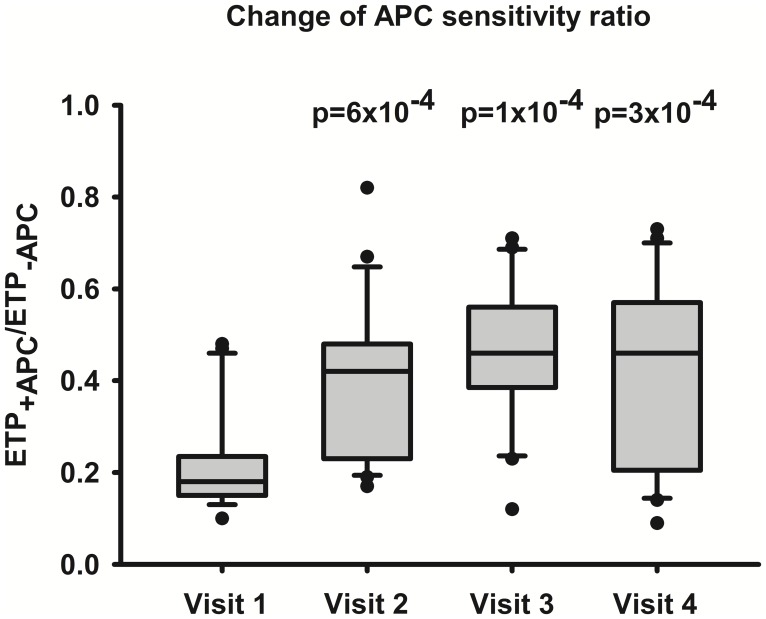
Change of the APC sensitivity ratio during the study period.Box-whisker plots show the ratio [ETP+APC/ETP−APC] at visits 1–4. The center horizontal solid line is drawn at the median. Top and bottom edges of the boxes are located at the sample 75th and 25th percentiles. Top and bottom of the whiskers are located at the 90th and 10th percentiles. Each outlier is shown. P values indicate the changes of visits 2–4 compared to visit 1.